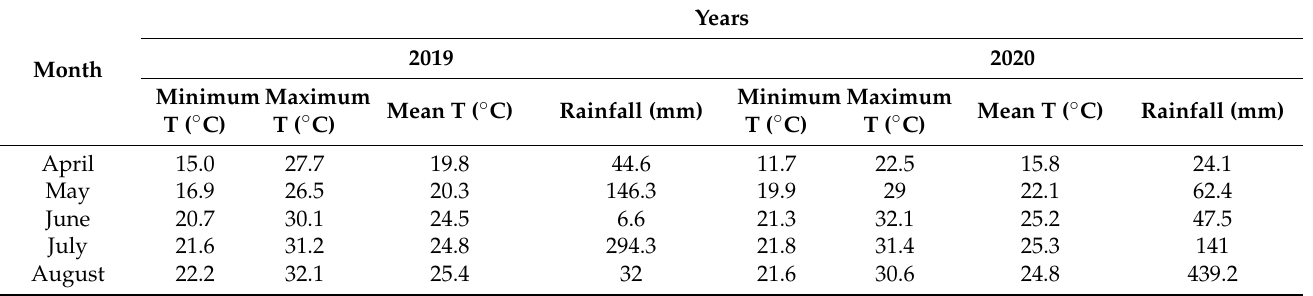
Table 1. Monthly minimum temperature, maximum temperature, mean temperature, and rainfall